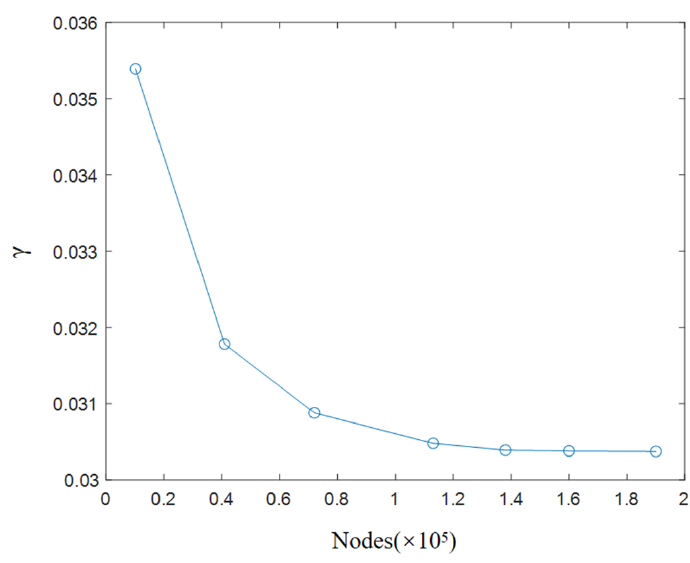
Figure 14. Grid independence verification. Figure 12. Grid independence